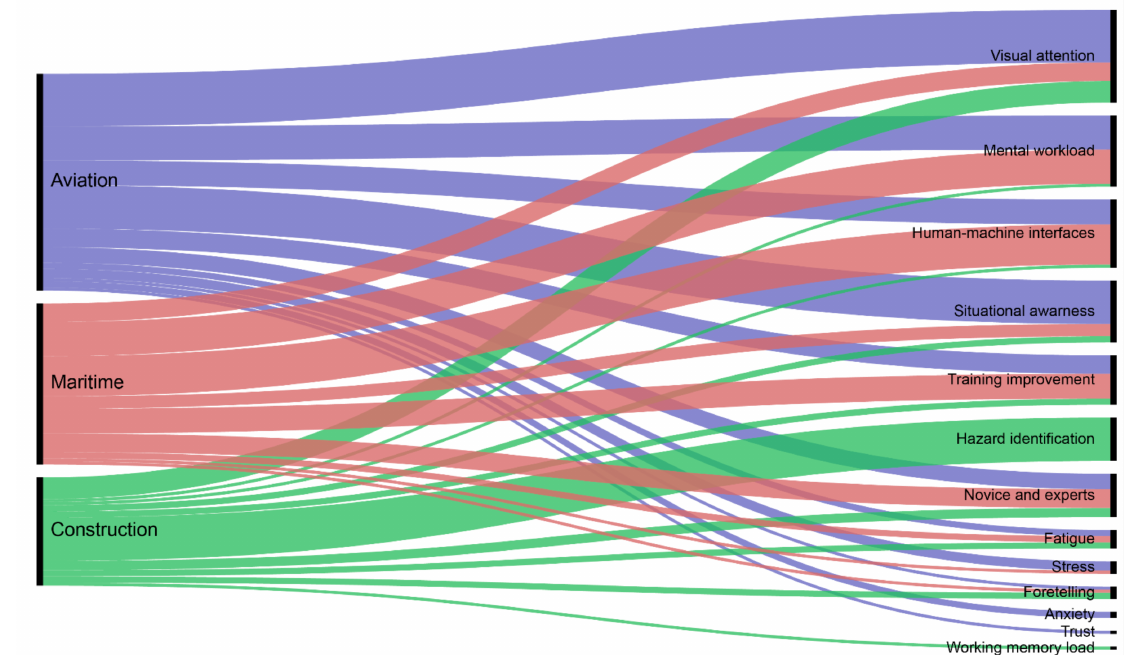
Figure 10. Different applications of eye tracking studies in the aviation, maritime, and construction industries (created with RAWGraphs